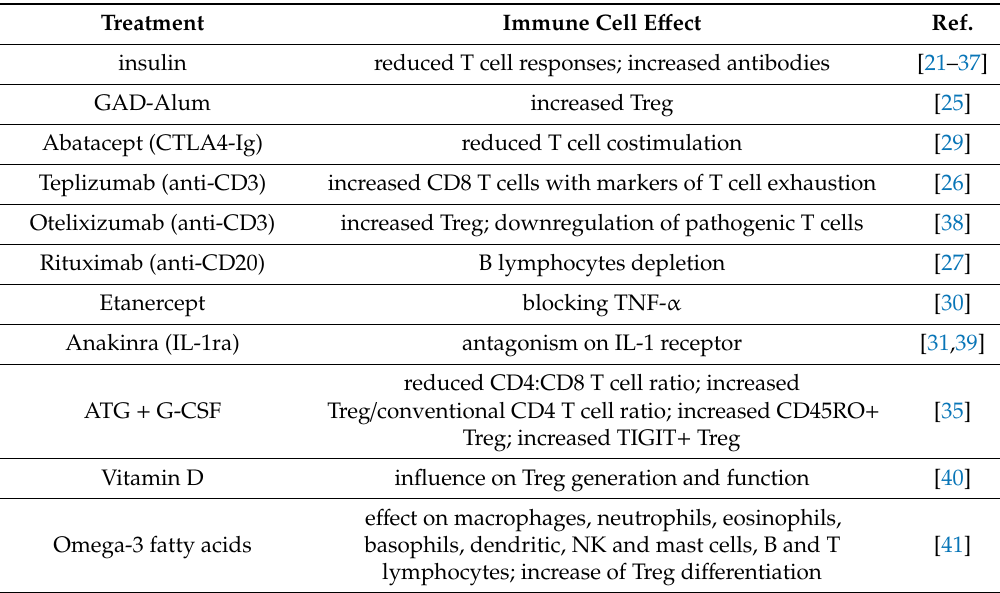
Table 3. E ff ects of di ff erent immunotherapies on immune